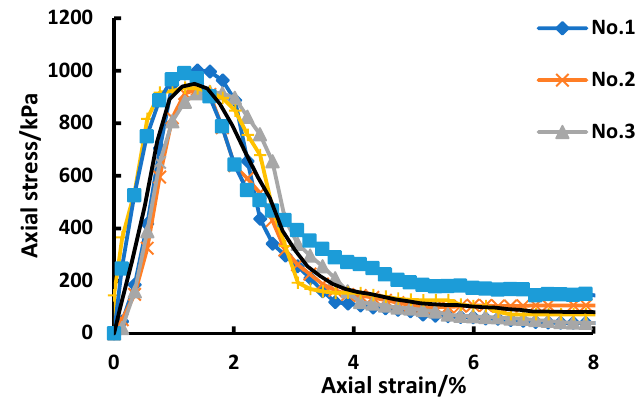
Figure 8. q- ε curve of STCS-0-0 .